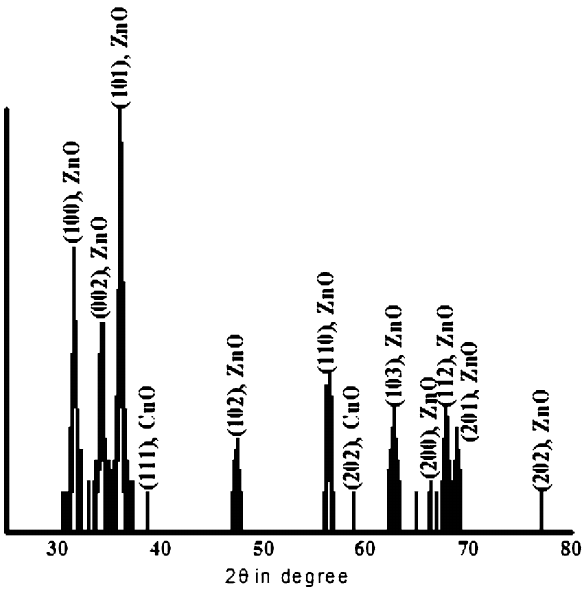
Fig. 3 XRD of ZnO–CuO nanocomposites